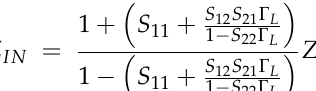
Figure 10. The input impedance of the SIR hairpin resonant filter.